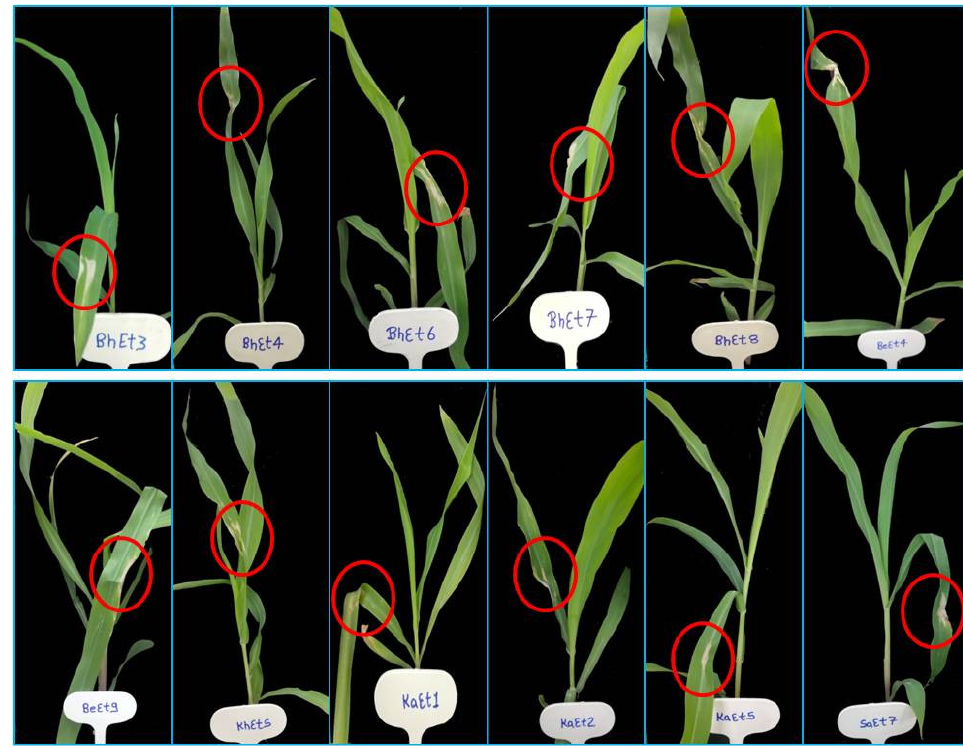
Figure 2. Disease reaction of E. turcicum race 3 on differential line ‘15′ after 14th days of inoculation.